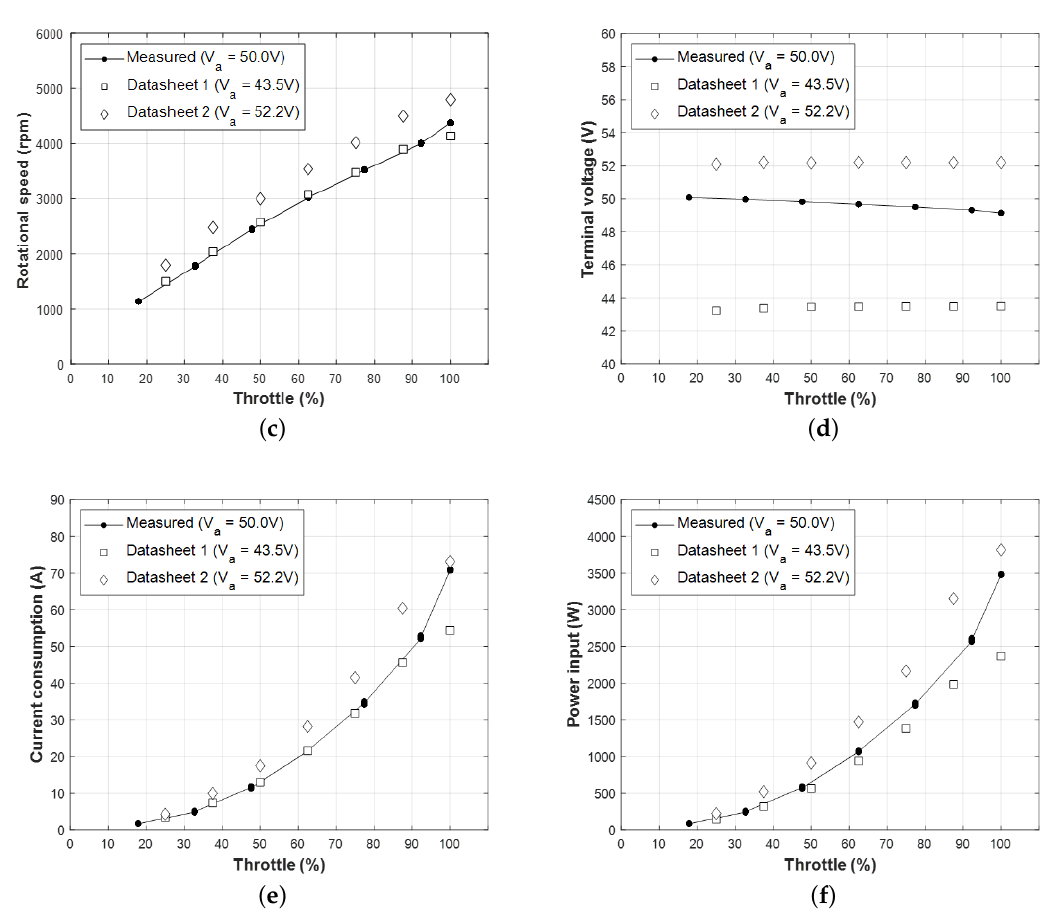
Figure 20. Static thrust test results of sample set 3 (KDE10218XF-105 with KDE-CF-305-DP) compared with datasheet: ( a ) Thrust, ( b ) torque, ( c ) rotational speed, ( d ) terminal voltage, ( e ) current consumption, and ( f ) power input.